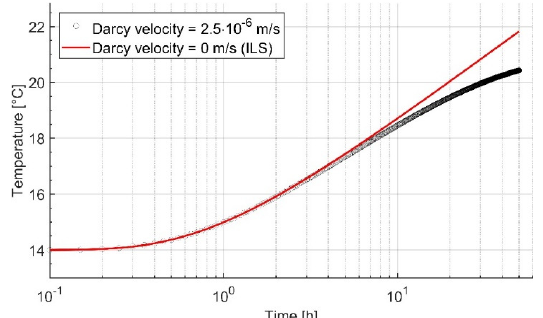
Figure 12. Evolution of borehole heat exchanger fluid temperatures in a heating process, considering groundwater flow against the conduction-based infinite line source [132].